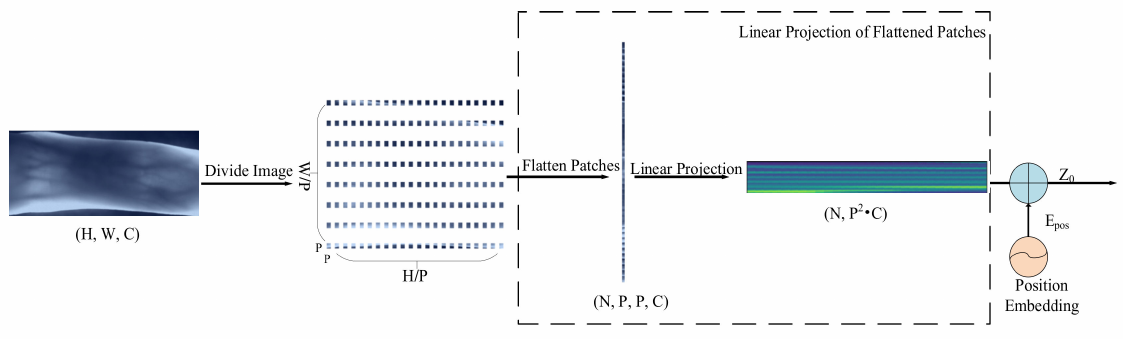
Figure 2. The first part of ViT-Cap model architecture: linear embedding of finger vein images. Transformers use a constant vector size D in all layers, so we flattened all the patches and mapped them to D dimensions through a trainable linear projection. The final em- bedded sequence of the patch, with the token Z 0 , is given in Equation (1), where x class is a learnable classification token that is needed to perform the classification task. The patch embeddings are the output of this